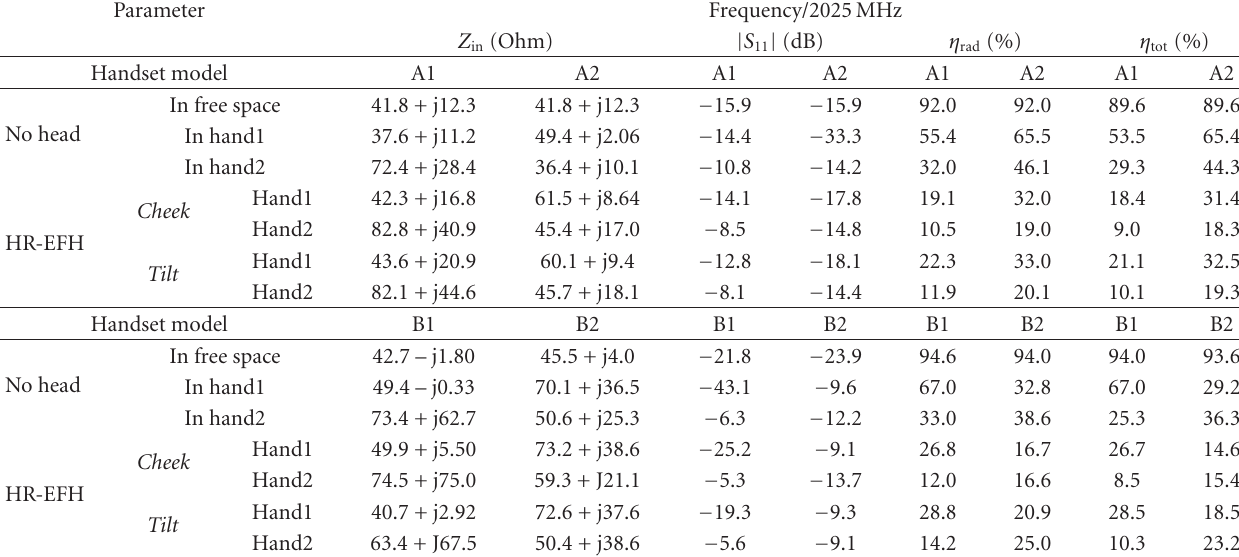
Table 6: Computational results of the antenna input impedance, Z in , | S 11 | in dB, radiation e ffi ciency, η rad , and total e ffi ciency, η tot , for di ff erent handset setups at 2025